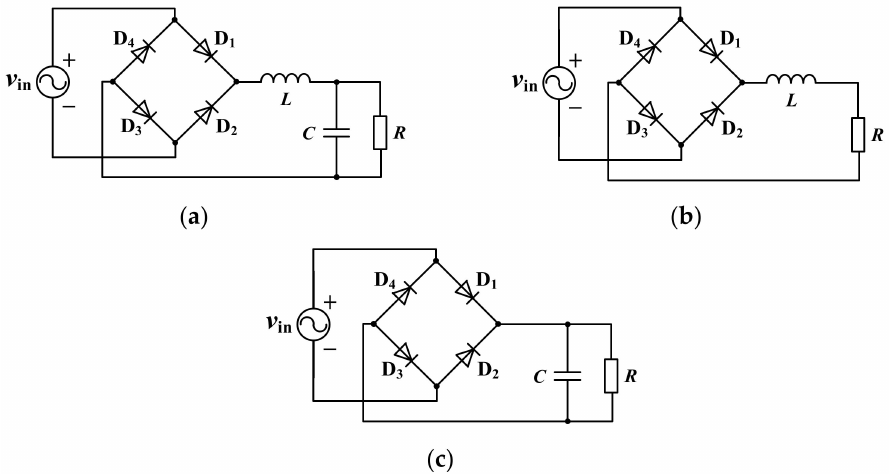
Figure 8. Memristive diode bridge circuit. ( a ) The diode rectifier bridge with LCR filtering; ( b ) the diode rectifier bridge with LR filtering; ( c ) the diode rectifier bridge with CR